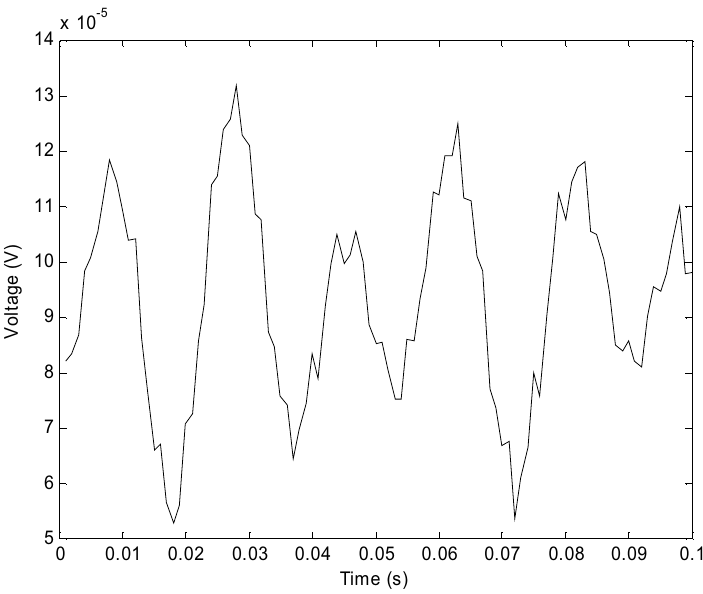
Fig. 13. PZT sensor voltage for the system rotating at 20 Hz. An upward step force is acting at the tip of the opposite blade. rotating speed and the time of rubbing contact is estimated based on the number of blades and the speed of rotation as 2.08 × 10 − 4 seconds. During the rubbing duration normal and tangential forces are applied. The normal force is F N = k s δ and the tangential force is F T = µ f F N . The data, based on a previous study by Al-Bedoor [21], suggests that k s = 10 7 , δ = 8 . 675 × 10 − 7 m and µ f = 0 . 2 , and therefore F N = 8.675 N and F T = 1.735 N.